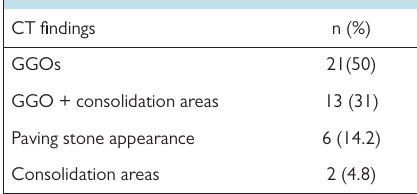
Table 2. Symptoms and Non-COVID-19 Diagnoses Symptoms